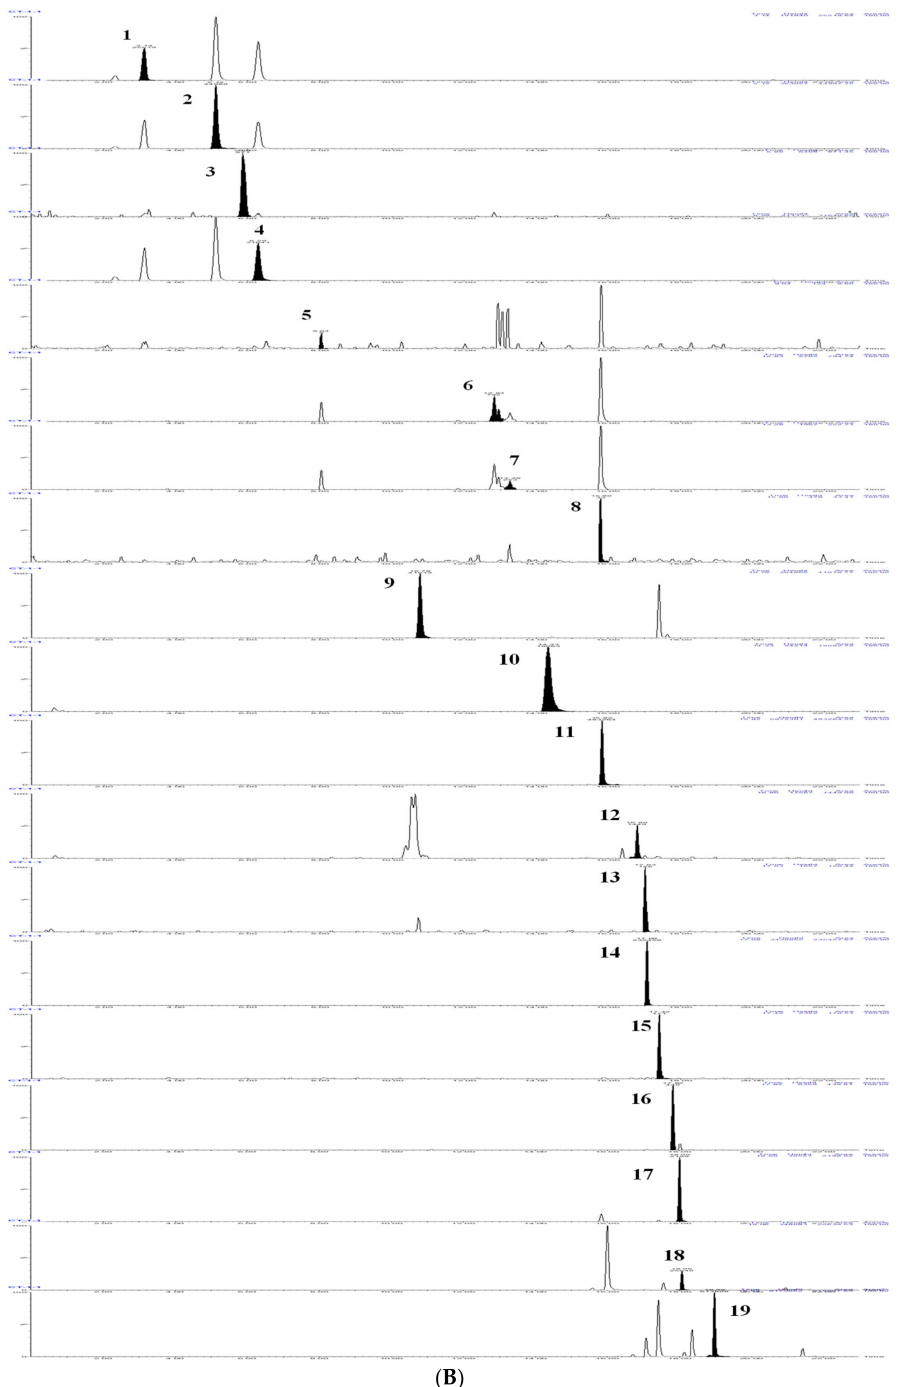
Figure 5. TQ chromatograms of the components to be measured in the mixed standards and the components to be measured in the samples. ( A ) TQ chromatogram of the components to be measured in the mixed standards. ( B ) TQ chromatogram of the components to be measured in the sample. Ac- cording to the peak order, the components are respectively: (1) Neochlorogenic acid; (2) Chlorogenic acid; (3) Caffeic acid; (4) Cryptochlorogenic acid; (5) 1,3-Dicaffeoylquinic acid; (6) Isochlorogenic acid B; (7) Isochlorogenic acid A; (8) Isochlorogenic acid C; (9) Luteolin-7- O - β -D-glucoside; (10) Apigenin-7-O- β -D-glucoside; (11) Diosmetin-7-glucoside; (12) Eriodictyol; (13) Luteolin; (14) Linarin; (15) Tilianin; (16) Apigenin; (17) Diosmetin; (18) Hesperidin; (19)